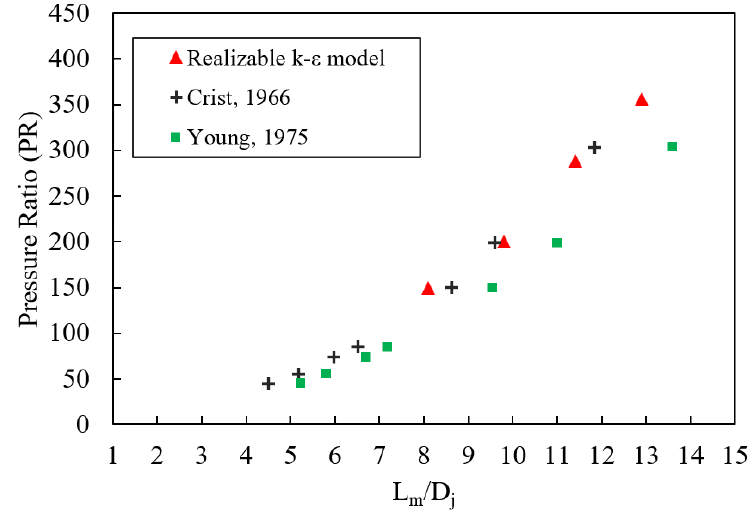
Figure 8. Pressure ratios vs. non-dimensional Mach disk location from nozzle exit [57,60].